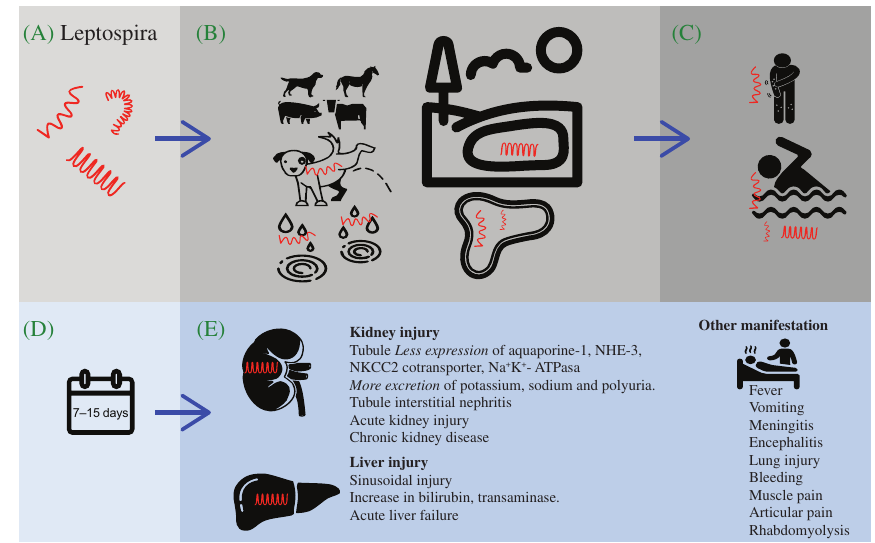
Figure 1. Transmission of Leptospira and the development of leptospirosis with its clinical manifestations: (A) Leptospira are strictly anaerobic bacteria belonging to the spirochetes genus; (B) Leptospira in infected rodents, dogs, pigs, cattle, and horses are the typical vectors; (C) The route of infection is through direct or indirect contact with contaminated tissues, urine, soils or water; (D) The incubation period is usually 8–12 days; (E) Pathophysiological and clinical manifestations of leptospirosis and the Weil’s